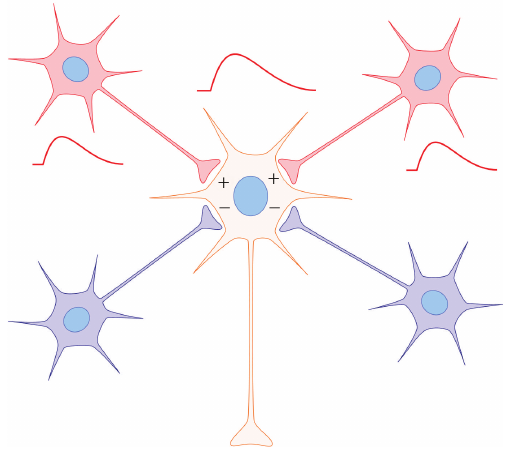
Figure 1: Hebbian plasticity. Classic Hebbian plasticity includes homosynaptic long-term synaptic potentiation (LTP) and long- term synaptic depression (LTD). Coincident activation in pre- synaptic neuronal inputs and the post-synaptic neuron strengthens specific synapses (shown in red). Inactive pre-synaptic inputs (or inputs out of phase with post-synaptic depolarization) are not potentiated and/or are depressed (shown in blue). The term “homosynaptic” refers to the fact that plasticity only occurs at the stimulated synapse.